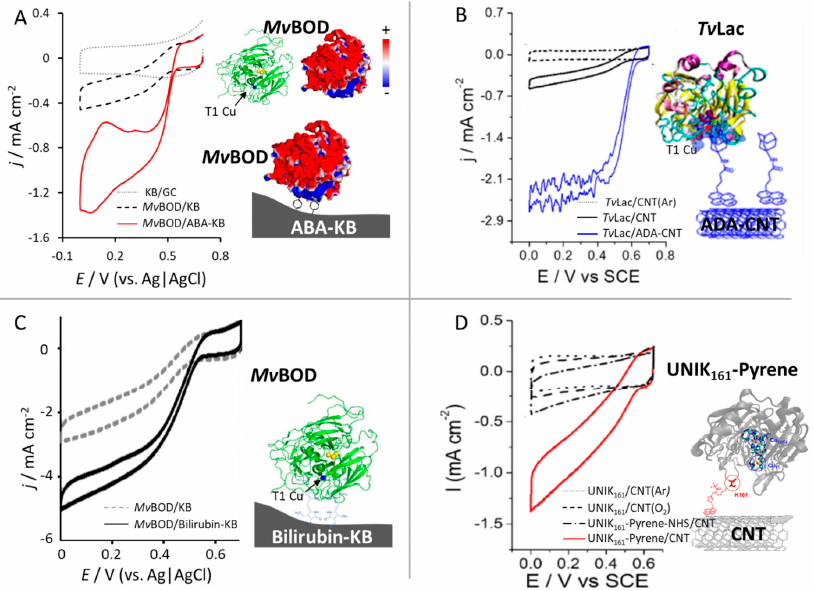
Figure 5. Examples of oriented immobilization of redox enzymes in modified carbon nanomaterials. ( A ) Cyclic voltammograms (CVs) of Mv BOD adsorbed in pristine KB (dashed line) and 4-aminobenzoic acid-functionalized KB (solid line) electrodes in an air-saturated phosphate buffer (0.1 M, pH 7.0) with a rotating rate of 2000 rpm. The dotted line shows the cyclic voltammogram of a bare KB electrode without Mv BOD. Reprinted from [47] Copyright (2016) with permission from Elsevier. ( B ) CVs of Tv Lac adsorbed in pristine CNTs (black solid line) and 1-pyrenebutyric acid adamantyl amide-functionalized CNTs (ADA-CNT, blue solid line) in a stirred oxygen-saturated McIlvaine buffer (pH 5). The dotted line shows the cyclic voltammogram of the Tv Lac adsorbed CNT electrode in an argon-saturated buffer. Reprinted from [62] Copyright (2016) with permission from American Chemical Society. ( C ) CVs of Mv BOD adsorbed in pristine KB (dashed line) and bilirubin functionalized KB (solid lines) electrodes in an O 2 -saturated phosphate buffer (0.1 M, pH 7) with a rotating rate of 4000 rpm. The inset shows the structure of bilirubin. Reprinted from [65] Copyright (2014) with permission from Royal Society of Chemistry. ( D ) CVs of the bare UNIK 161 (dotted line), UNIK 161 –NHS–pyrene (dashed-dotted line), and UNIK 161 –pyrene (solid line) adsorbed in CNT electrodes in O 2 -saturated 0.1 M phosphate buffer (pH 5.0). The dotted line shows bare UNIK161 adsorbed CNT electrodes in an argon-saturated buffer. UNIK 161 is a variant of the LAC3 enzyme (GENEBANK AAR00925.1) containing lysine, methionine, and histidine residues replacing arginine R161 (R > K161) and lysines K40 (K > M40) and K71 (K > H71) in the native sequence, respectively; in addition, UNIK161–NHS–pyrene indicates that the enzyme was modified with pyrene–NHS, which was randomly attached to UNIK 161 through an activated ester coupling. UNIK 161 –pyrene is produced through the highly selective modifications of K161 with pyrene Rreprinted from [73] Copyright (2016) with permission from American Chemical